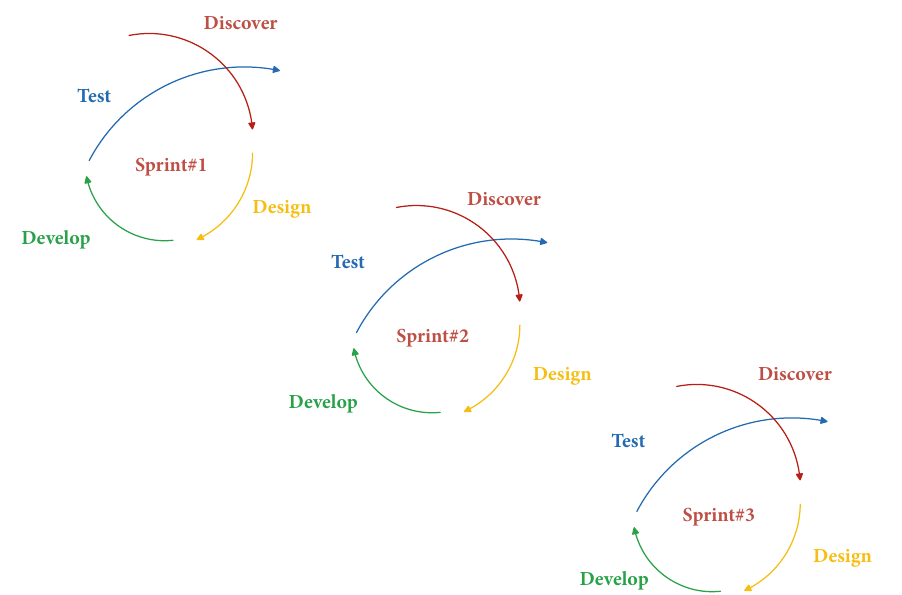
Figure 10: The iterative